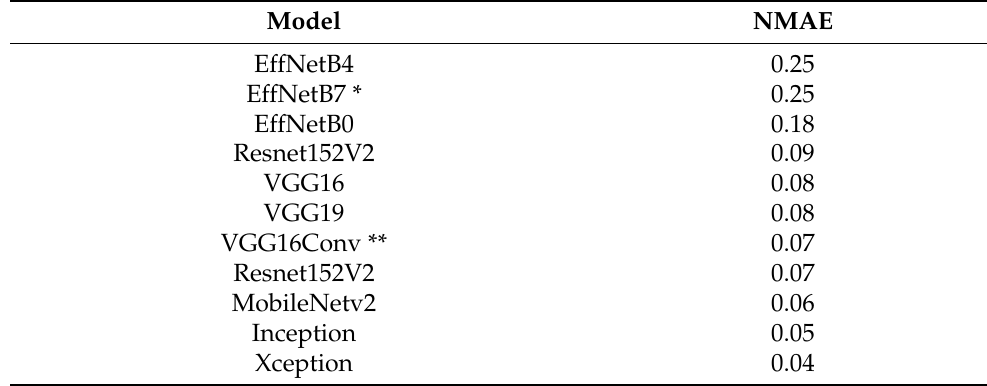
Table 1. Model comparison for various built-in Keras models. Error is given as mean absolute error over the test set in normalized coordinates (NMAE). Note that performance should be about 0.25, the average distance to the center along either axis, if the model solely guesses (0.5, 0.5), the middle of the ROI, as an output. * EffNetB7 became overfitted extremely early in training. ** VGG16Conv was a custom modification of a smaller VGG-type architecture where pooling layers were replaced with strided convolution layers.